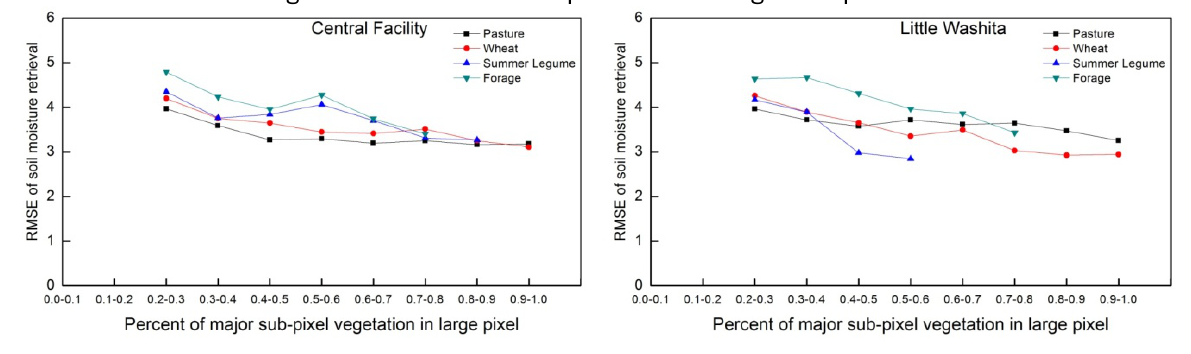
Figure 8. Land-cover heterogeneity impact on soil moisture retrieval using active microwave data. Higher values of x-axis represent a homogenous